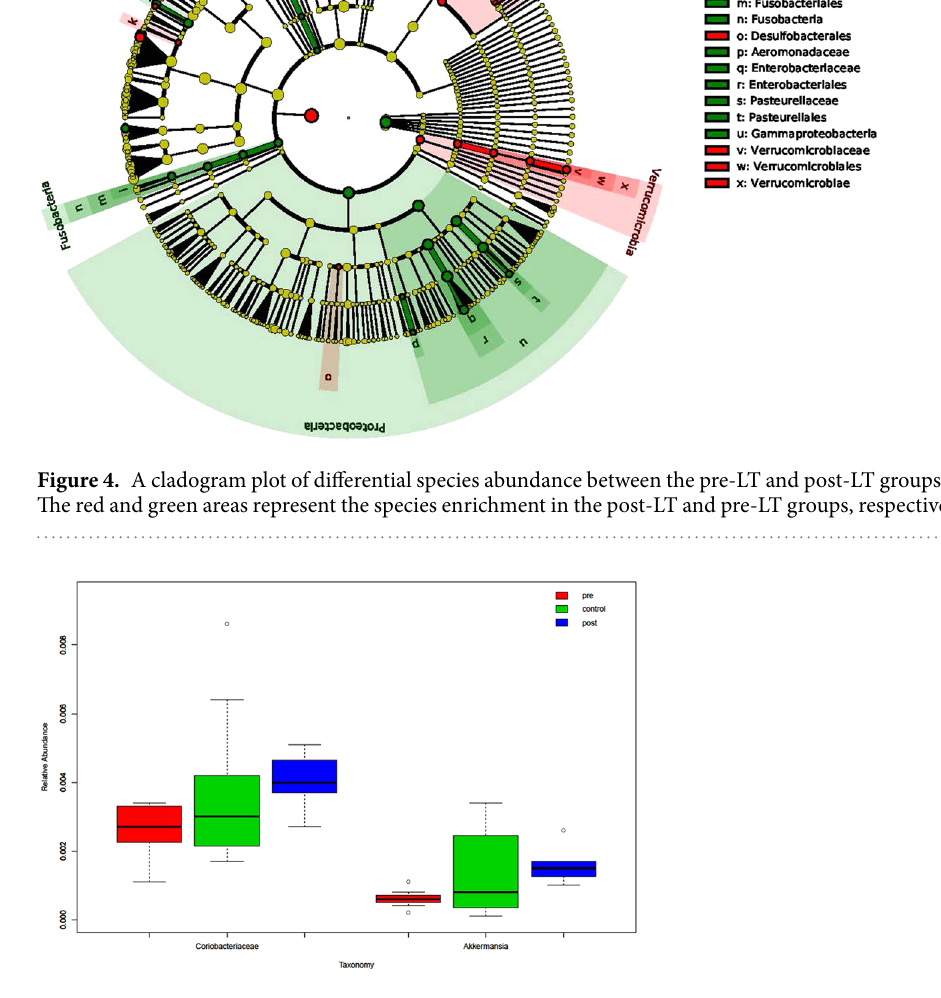
Figure 5. The distributions of Coriobacteriaceae and Akkermansia in all samples from the pre-LT, post-LT, and healthy control groups are